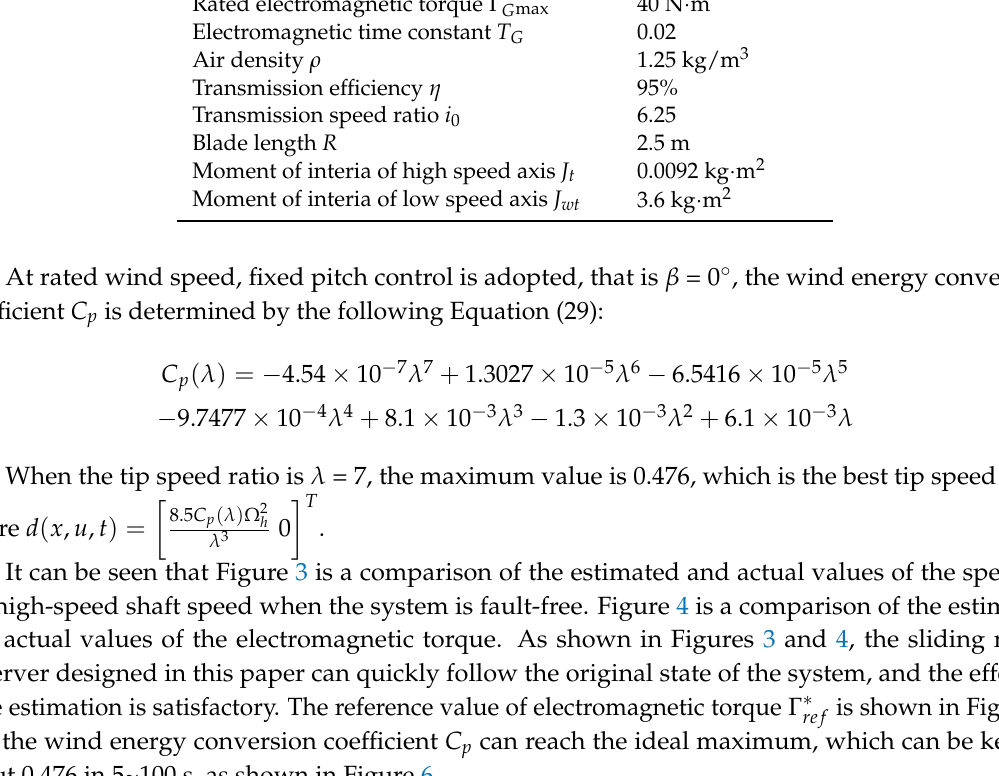
Figure 3. Actual and estimated values of speed Ω h of high speed shaft.